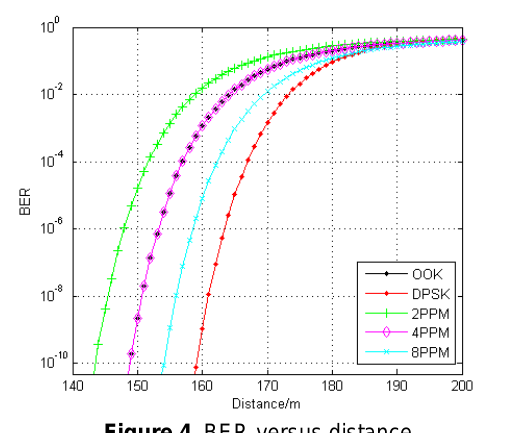
Figure 4. BER versus